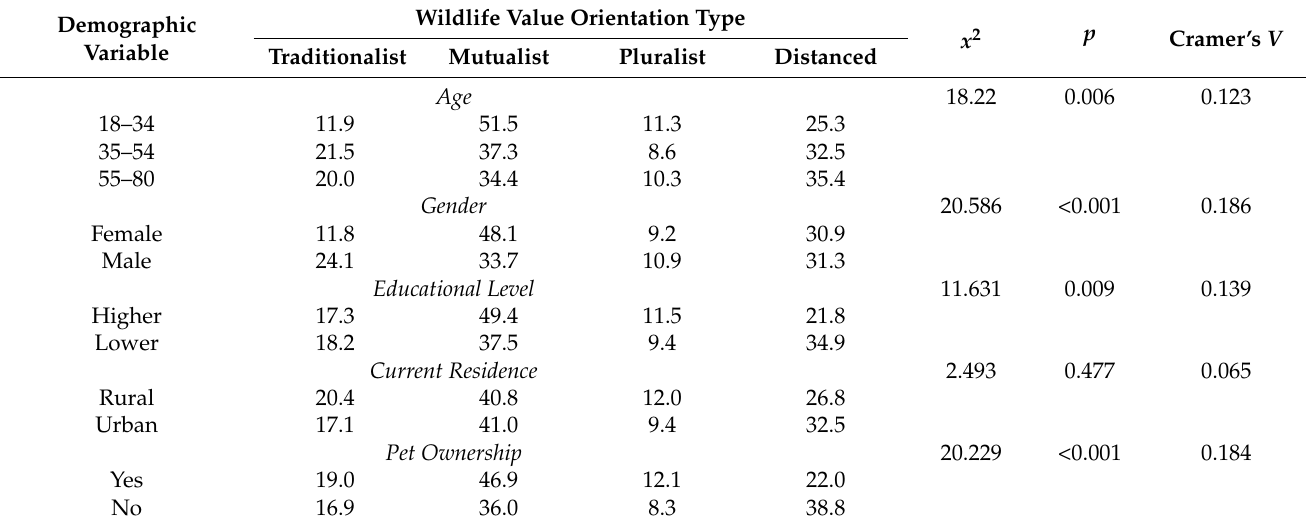
Table 4. Wildlife value orientation types by demographic characteristics of the Greek population